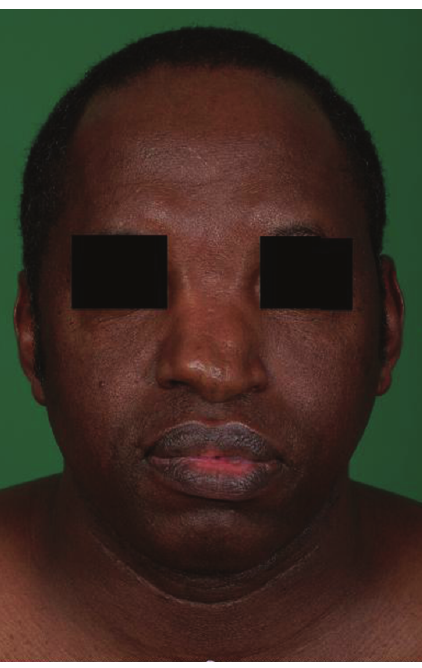
Figure 1: Facial appearance of our patient. Image shows a broad dorsum and asymmetrical tip of the nose with mild hypertelorism. This is likely to represent a congenital craniofacial